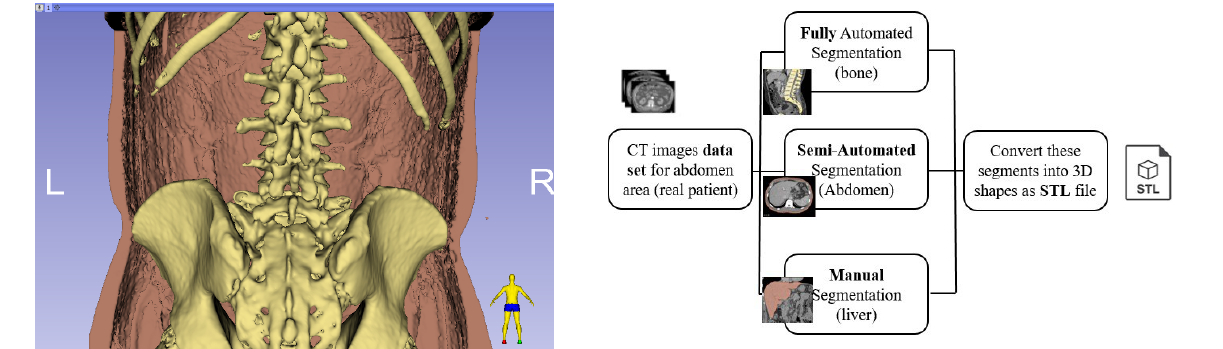
Figure 7: 3D Longitudinal sector of real human bone and abdomen model, and a Flow chart for segmentation procedures